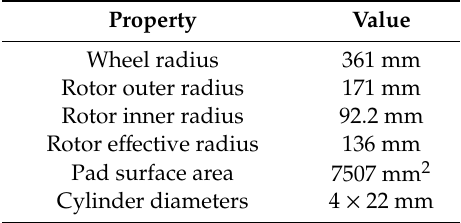
Table 1. The main properties of the car and disc brake.